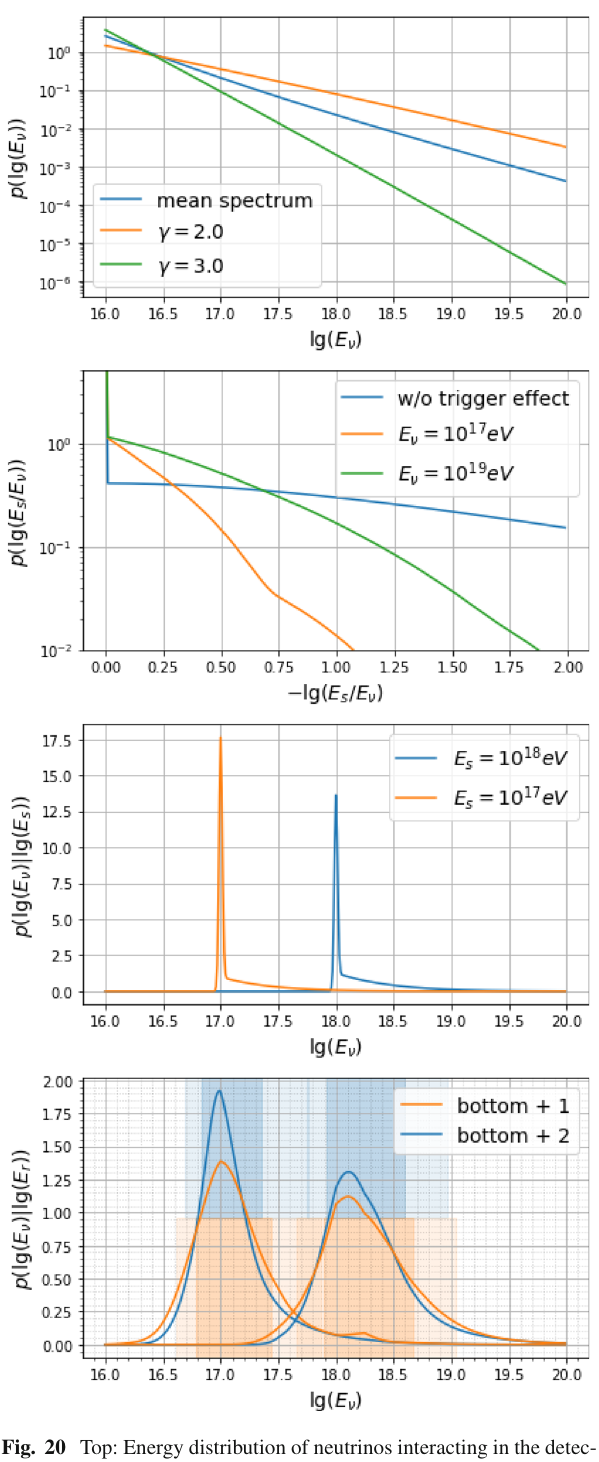
Fig. 20 Top: Energy distribution of neutrinos interacting in the detec- torvolume assumingapower lawspectrumwithspecificindices(green, orange) and over a distribution of spectra (blue). Second row: Distribu- tion of the fraction of the neutrino energy that goes into the shower for neutrino-nucleon interactions (blue) and the distribution when trigger efficiencies are included (orange, green). Third row: Probability for a shower with a given energy to have been generated by a neutrino with energy E ν . Bottom: The same distribution as above, but assuming an uncertainty on the reconstructed shower energy. The shaded regions mark the 68% and 90% quantiles of the